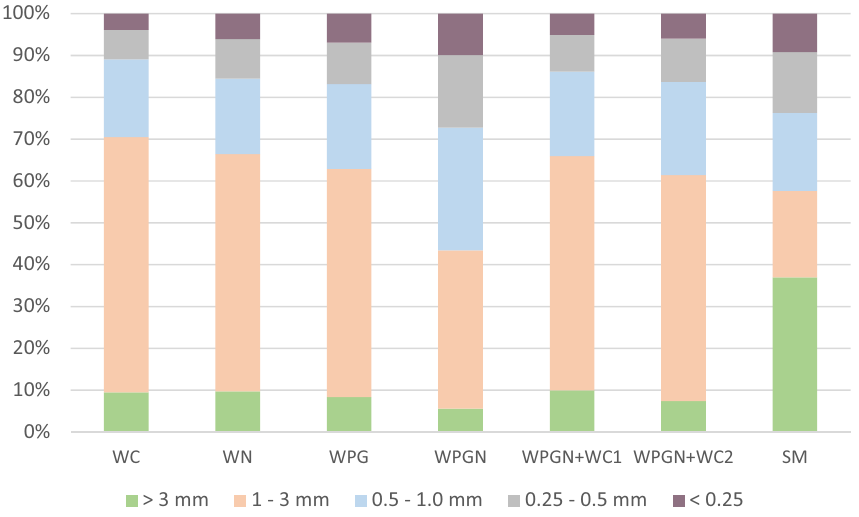
Figure 1. Horticulture media structure (% of biomass fraction). WC, willow compost; WN, willow compost with mineral nitrogen; WPG, willow compost with Phanerochaetaceae decom-poser; WPGN; willow compost with Phanerochaetaceae decomposer and mineral nitrogen; WPGN + WC(1), willow compost mixtures in proportion 25:75%; WPGN + WC(2), willow compost mixtures in proportion 50:50%; SM, sphagnum moss substrate.